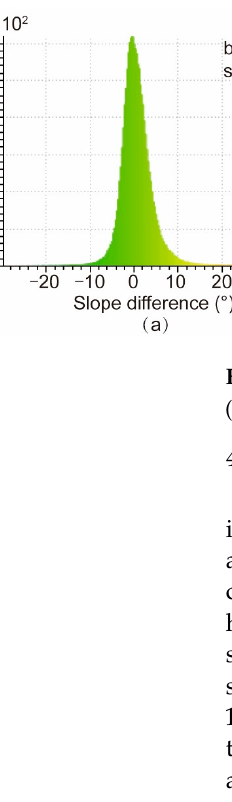
Figure 9. The distribution of the slope of the terrain derived from ( a ) the airborne LiDAR DEM, ( b )